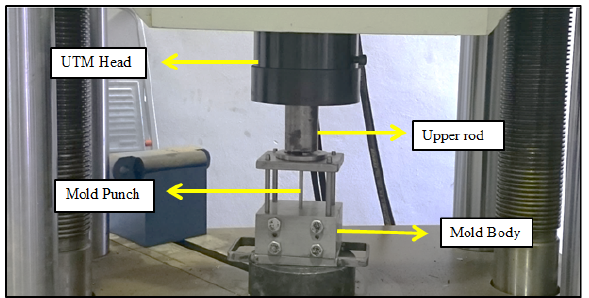
Figure 3: Compaction process using